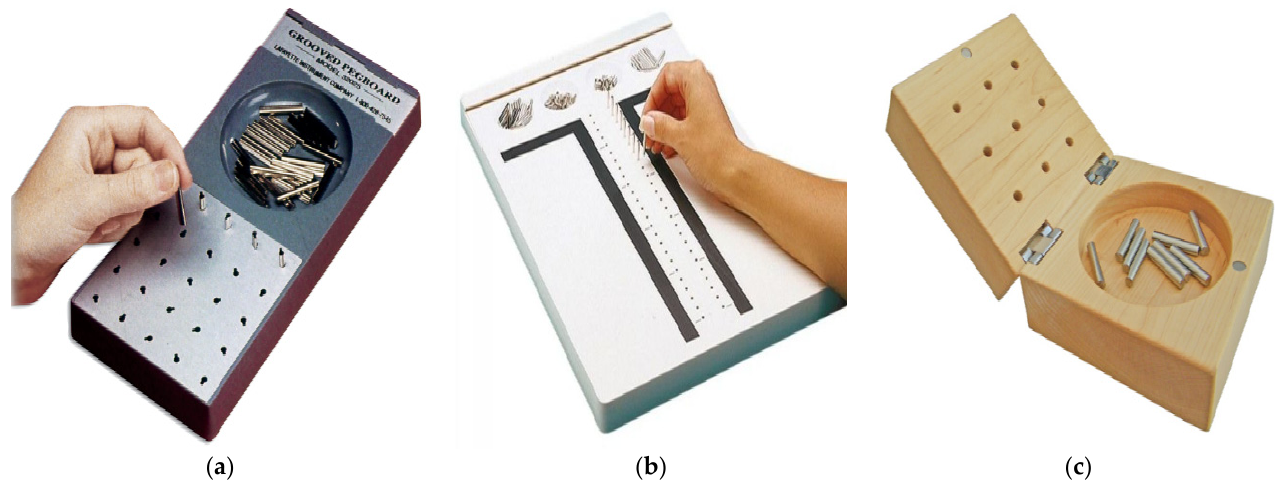
Figure 1. Three examples of different types of Pegboard Tests: ( a ) Grooved Pegboard Test (GPT), ( b ) Purdue Pegboard Test (PPT), and ( c ) Nine Holes Peg Test (NHPT).